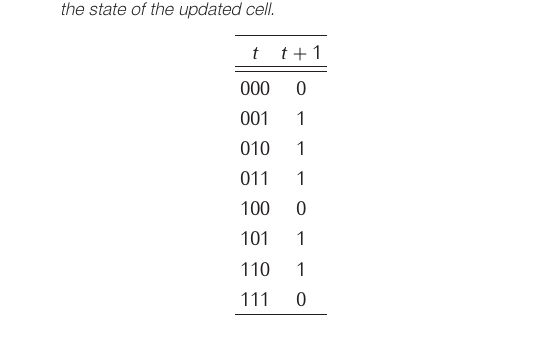
Table 2. ECA110lookuptable. Thefirstcolumnshowstheeightpossiblestates ofthe3cellsusedtoupdateeverycell,whilethesecondcolumnshows the state of the updated